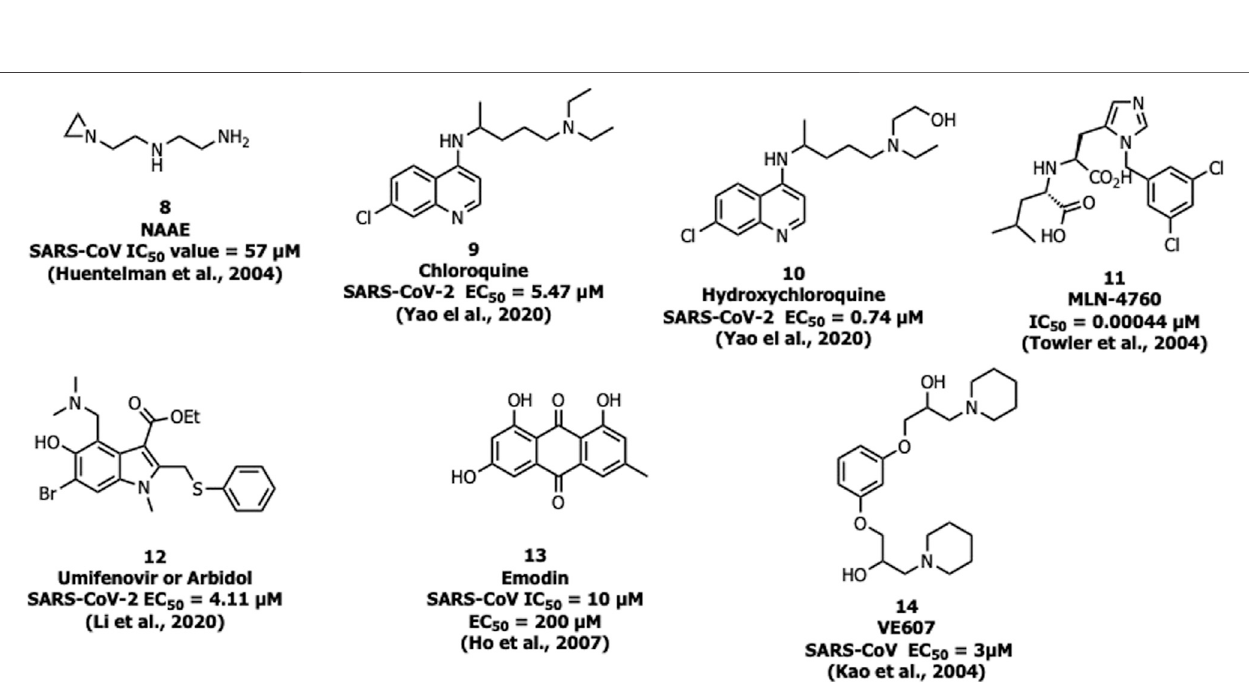
FIGURE 6 | Inhibitors for SARS-CoV-1 and -2 targeting ACE2.